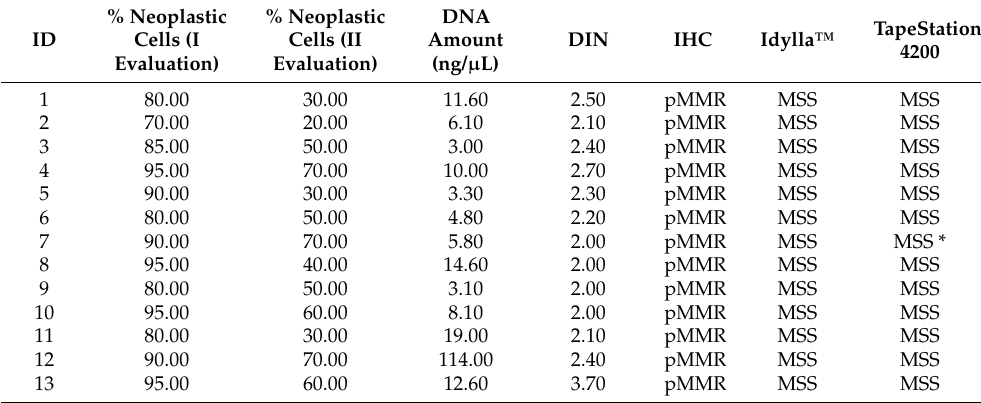
Table 3. Summary of molecular analysis of MMR/MSS status for pancreas cancer